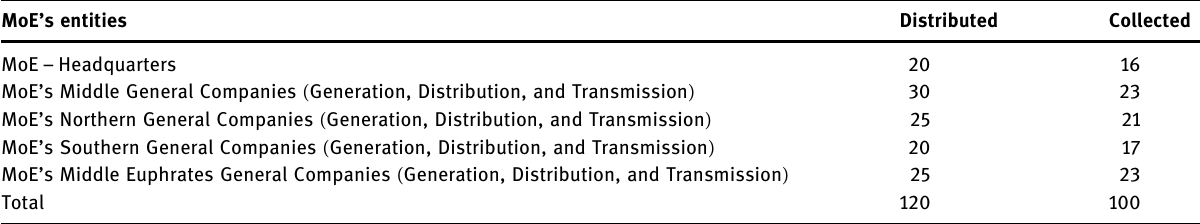
Table 3: The pro fi le of the respondent MoE ’ s